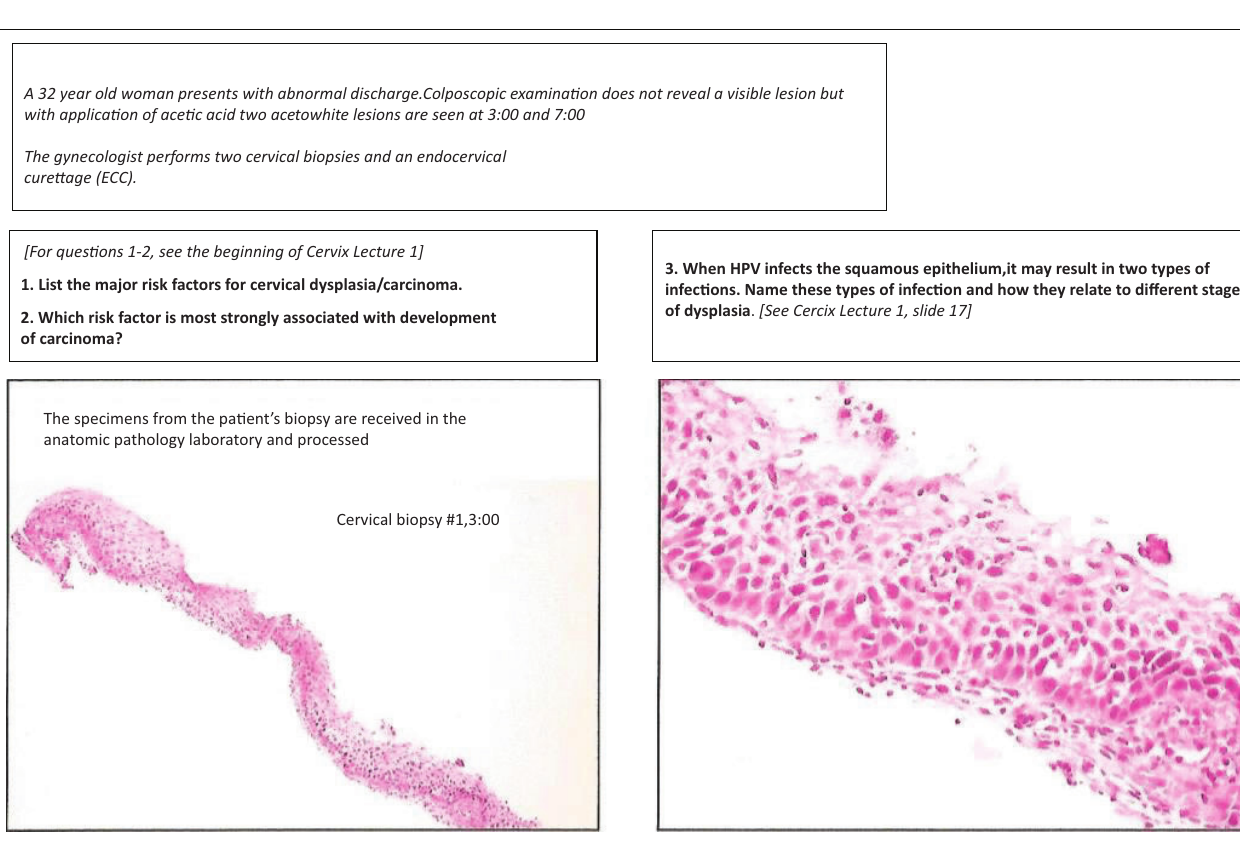
Supplementary Figure 1: Flow chart of pilot testing process.